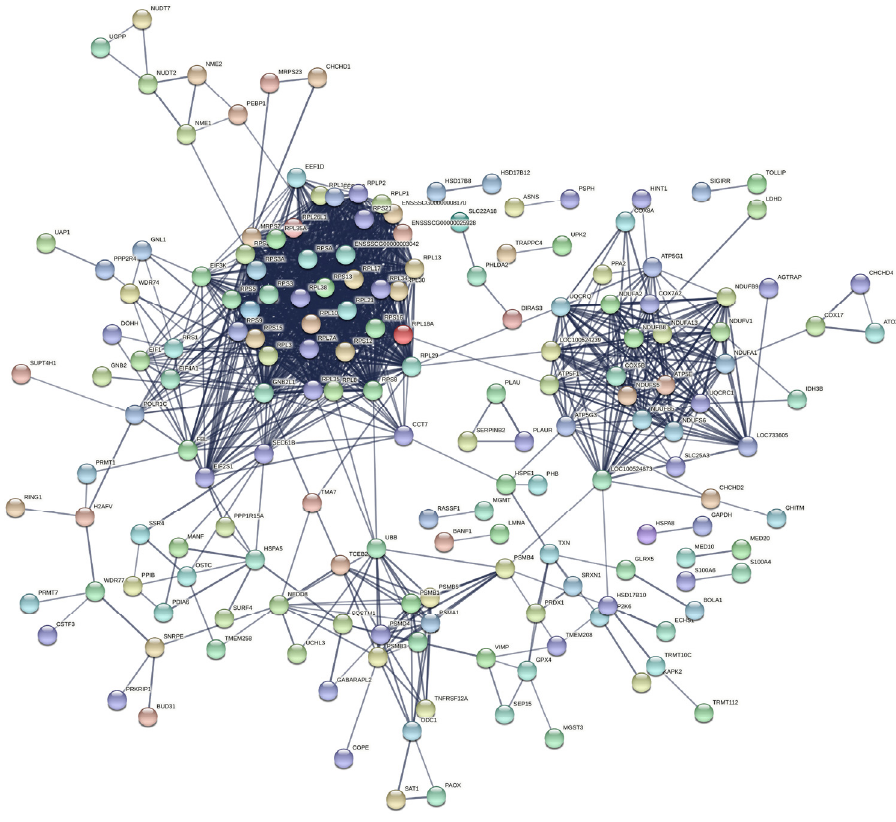
Figure 7. PPI analysis of the downregulated DEGs in the E. coli and E. coli + pBD2 groups.